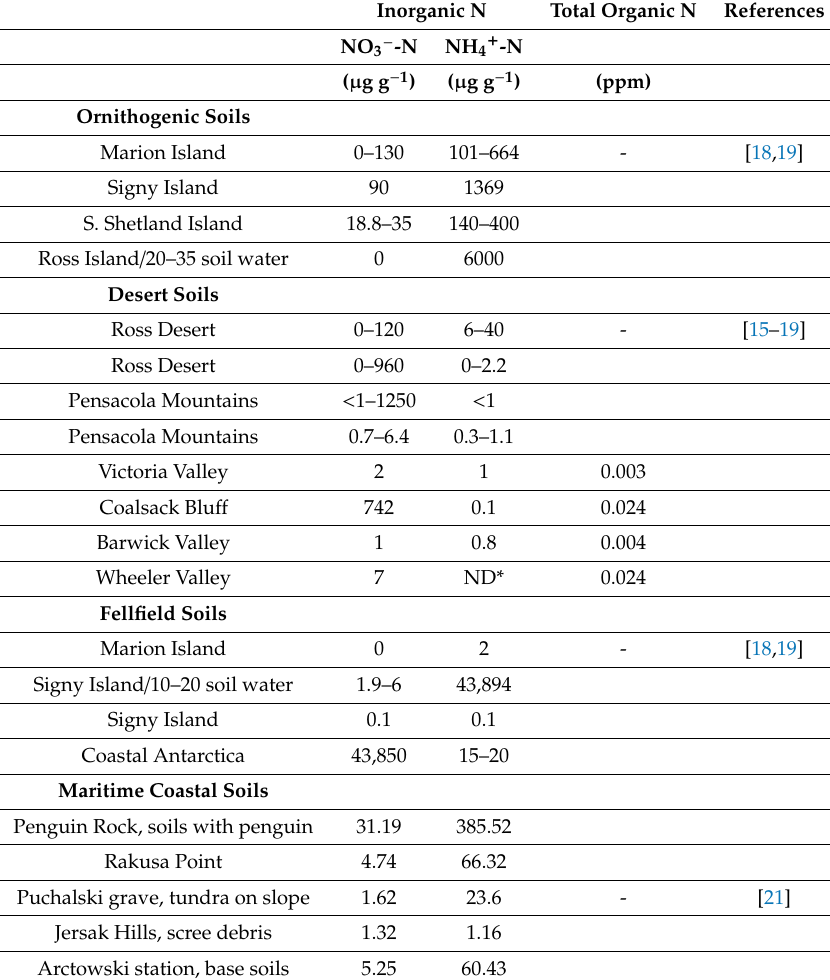
Table 1. Soil nitrogen levels in various Antarctic soils. (* Not determined) Inorganic N Total Organic